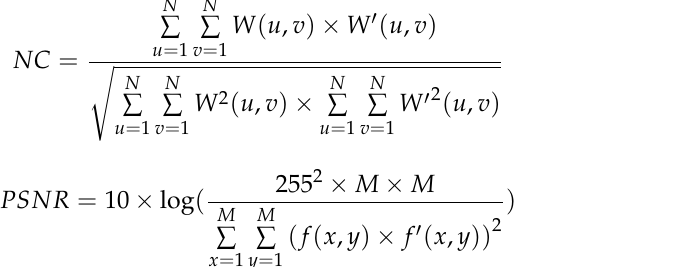
Figure 8. Medical image and extracted watermarking without attack: ( a ) medical image; ( b ) extracted watermarking image.